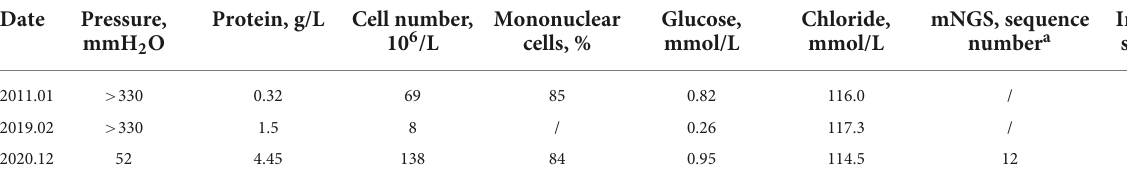
TABLE 1 Cerebrospinal fluid results of three examinations.